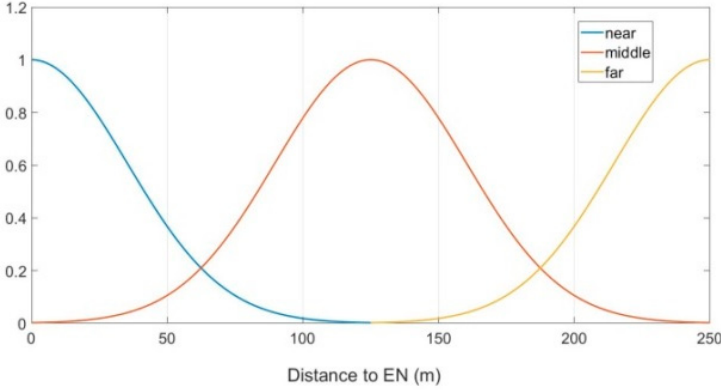
Figure 3. Subordinating degree function of parameter D with r = 250.